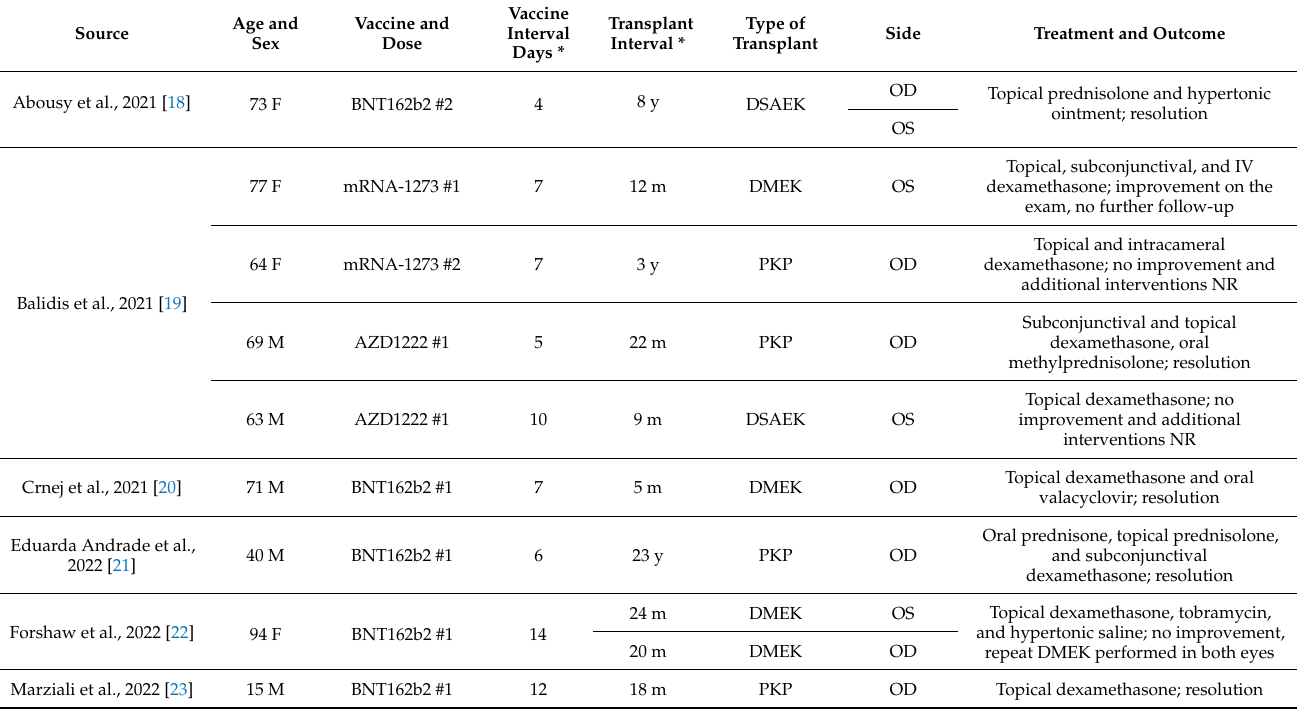
Table 1. Patient information from reviewed case reports and case series of corneal graft